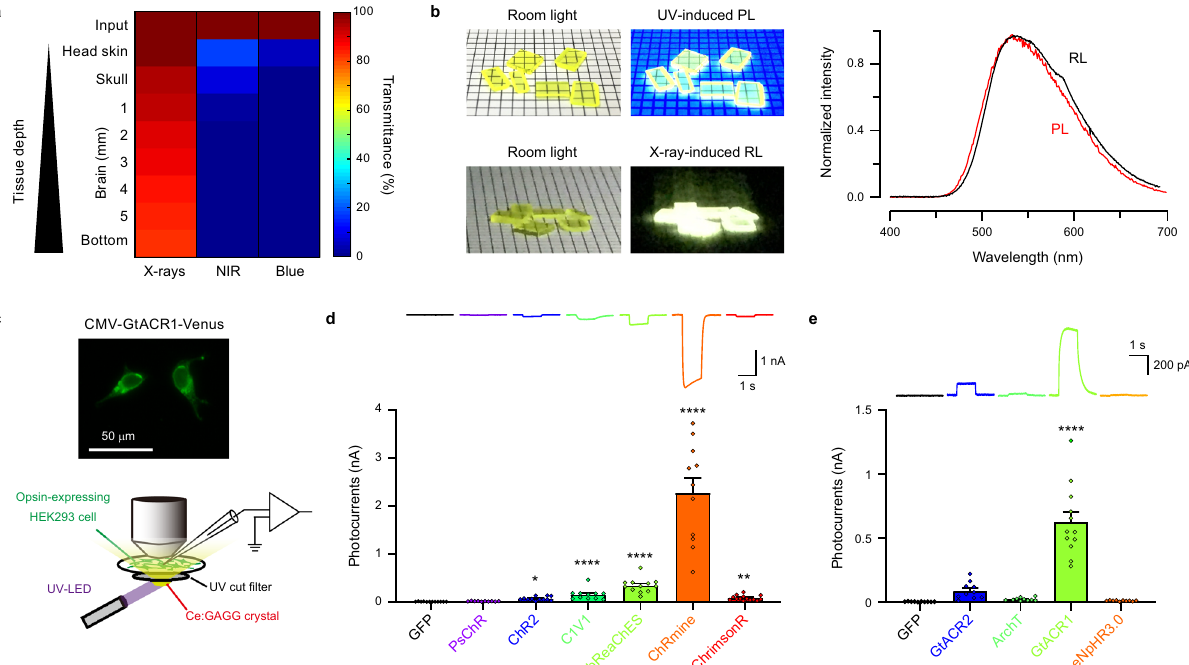
Fig. 1 Potential of Ce:GAGG scintillation for application in deep brain optogenetics. a Tissue transmittance of X-rays (150 kV, 3 mA), NIR (976 nm), and blue light (470 nm) penetrating through mouse head tissues from a dorsal position. Values were estimated using the data shown in Supplementary Fig. 1. b Left, Ce:GAGG crystals under room light. Middle, Ce:GAGG crystals under UV (365 nm) and X-rays (150 kV, 3 mA). Right, spectra of RL (black) and PL (red) emitted by a single Ce:GAGG crystal. The luminescence intensity was normalized at the peak. Grid-scale, 2 mm. c Top, the epi- fl uorescence image of HEK 293 cells expressing GtACR1-Venus. Similar fl uorescence images were observed in 30 recording sessions (134 cells in total). Bottom, schematic of the photo-current recording. d Representative photocurrents (top) and photocurrent amplitudes (bottom) of different excitatory opsins and GFP induced by Ce:GAGG PL (GFP, n = 12 cells; PsChR, n = 10 cells, p > 0.9999; ChR2, n = 12 cells, * p = 0.0205; C1V1, n = 11 cells, **** p < 0.0001; bReaChES, n = 12 cells, **** p < 0.0001; ChRmine, n = 11 cells, **** p < 0.0001; ChrimsonR, n = 14 cells, ** p = 0.0047; Dunn ’ s multiple comparison test vs. GFP, two-sided). PL power: 1.8 mW/cm 2 . e Same as d but with inhibitory opsins and GFP (GFP, n = 10 cells; GtACR2, n = 10 cells, p = 0.440; ArChT, n = 10 cells, p = 0.994; GtACR1, n = 12 cells, **** p < 0.0001; eNpHR3.0, n = 10 cells, p = 0.9998; Dunnett ’ s multiple compariso n test vs. GFP, two-sided). PL power: 1.8 mW/cm 2 . Circles in d and e indicate individual cells. Values are mean ±